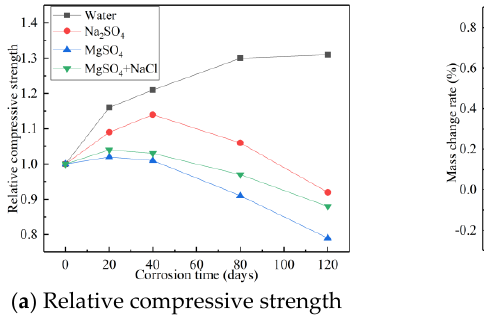
( c ) Relative dynamic elastic modulus Figure 6. Influences of Mg 2+ on Physical Properties of MK Concrete.